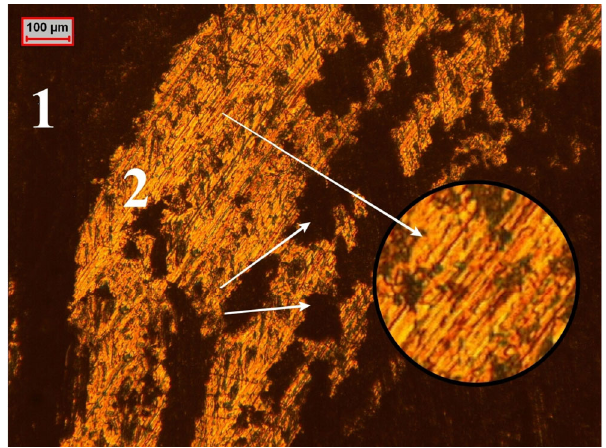
Fig. 9 Polarized light optical micrograph of sample CpC10 representing voids from chipping along with mild abrasion.